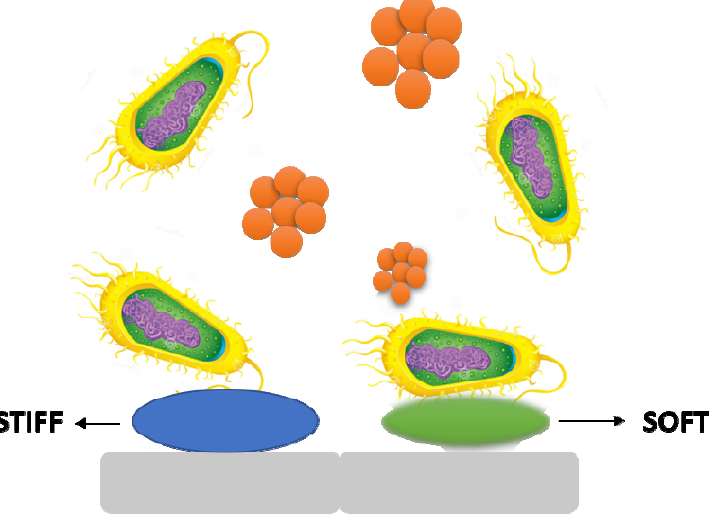
Figure 6. The stiffness of a material has an effect on bacterial adhesion and cell activity.